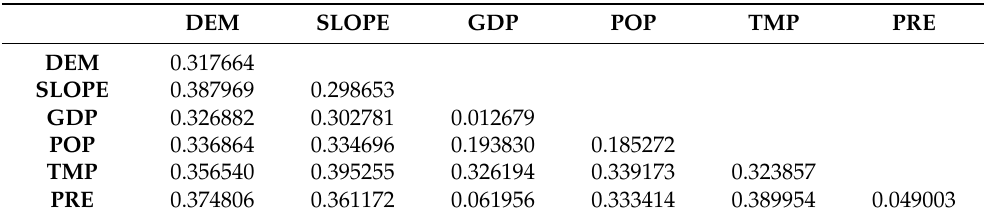
Table A4. The force (q-value) among any two influencing factors on Edge density (ED) interactively in 1990.